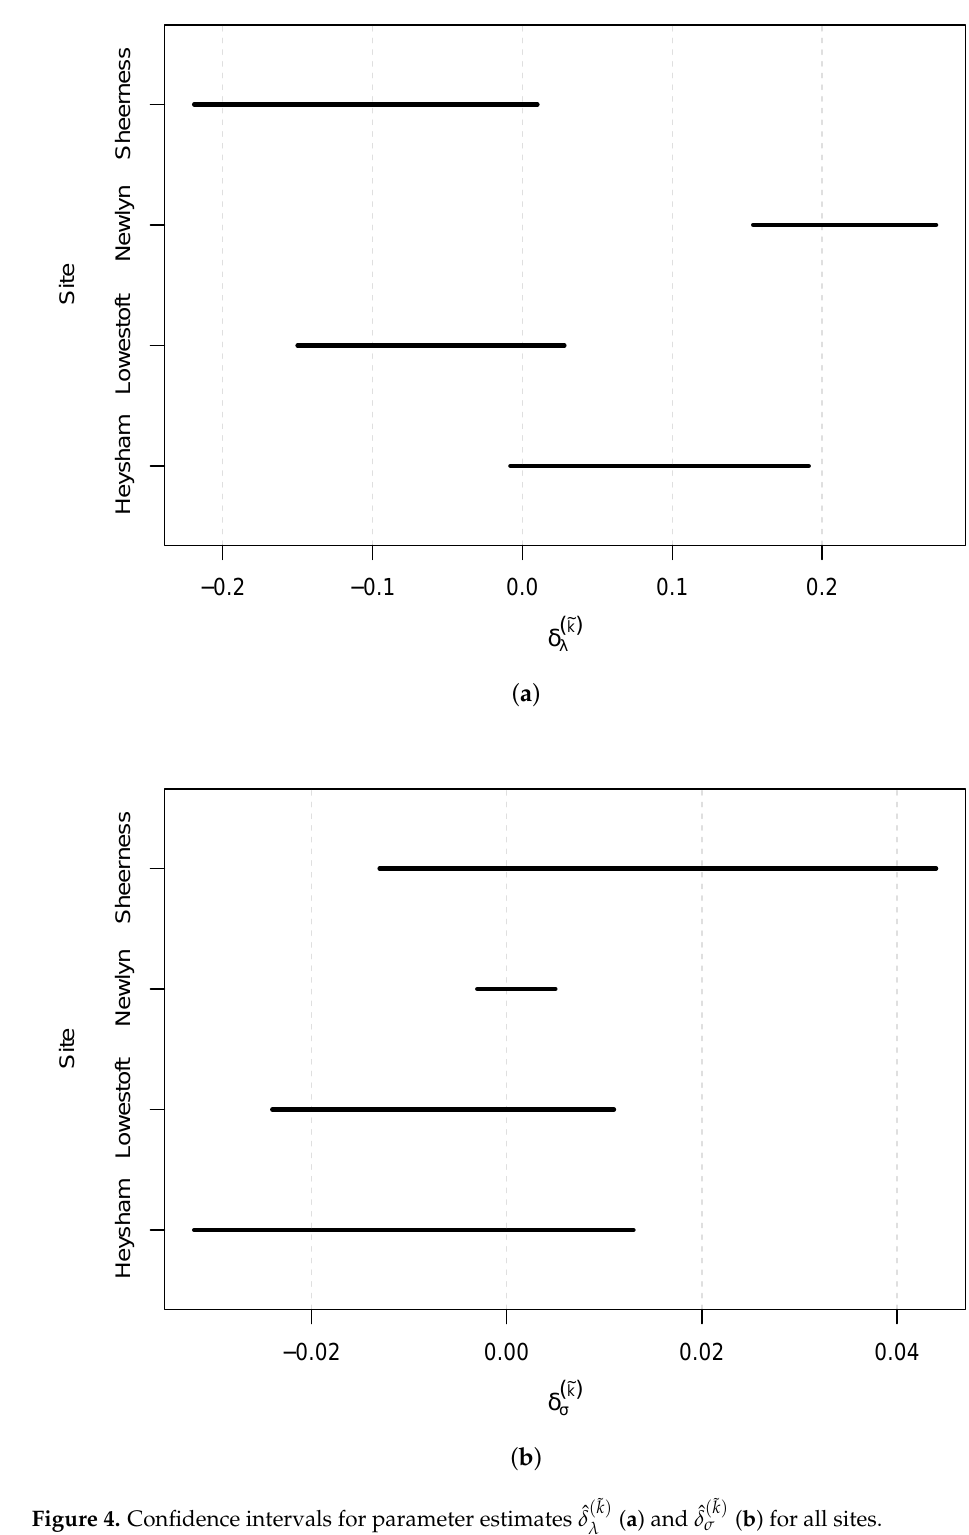
( ˜ k ) ( ˜ k ) ( a ) and ˆ δ σ ( b ) for all sites. λ